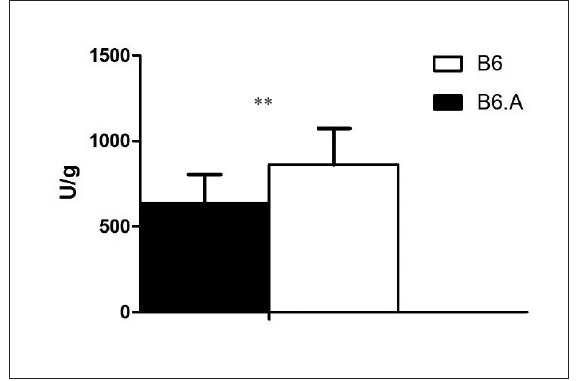
Figure 1. Citrate synthase’ activity (U/g) in B6 and B6.A mice mitochondria Note. ** p < .05.